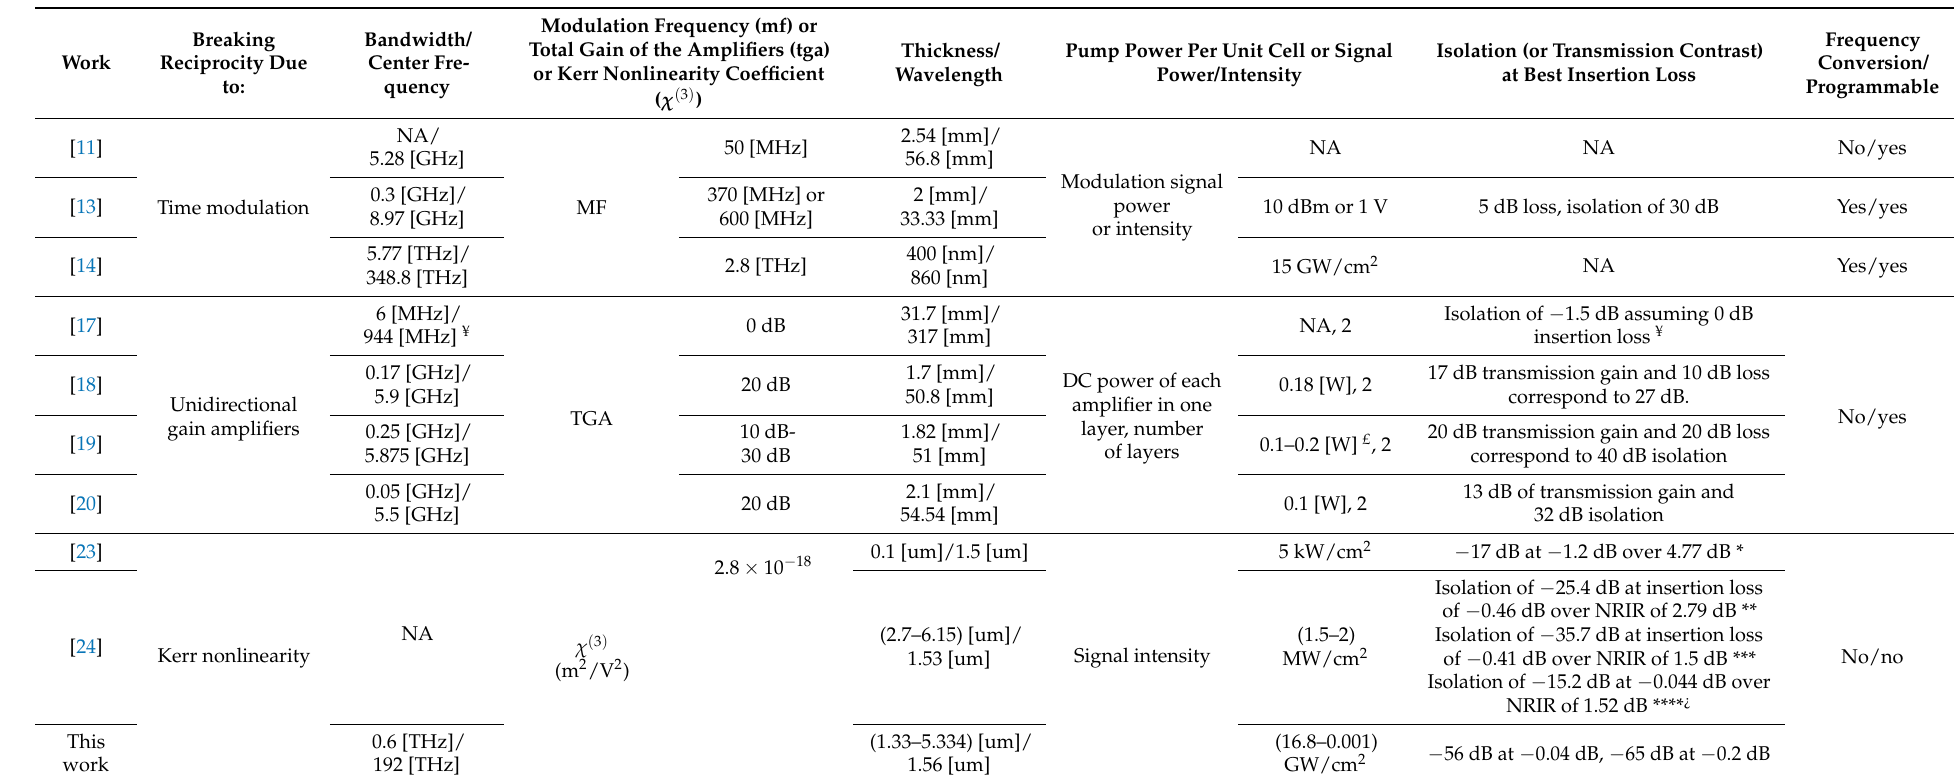
Table 1. Comparison between the different approaches used to realize free space